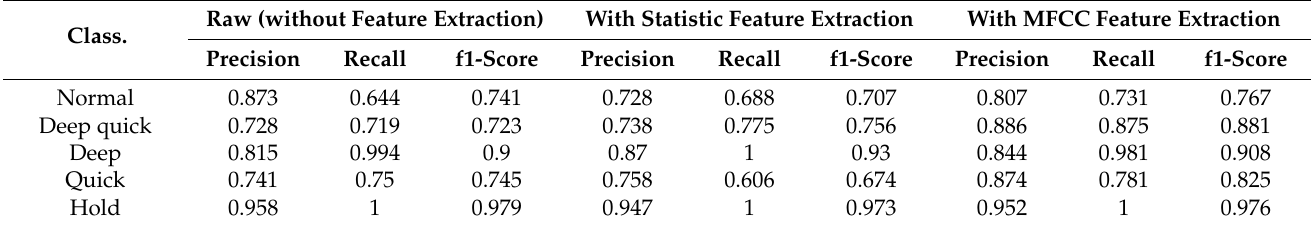
Table 5. Classification report for confusion matrix in Figure